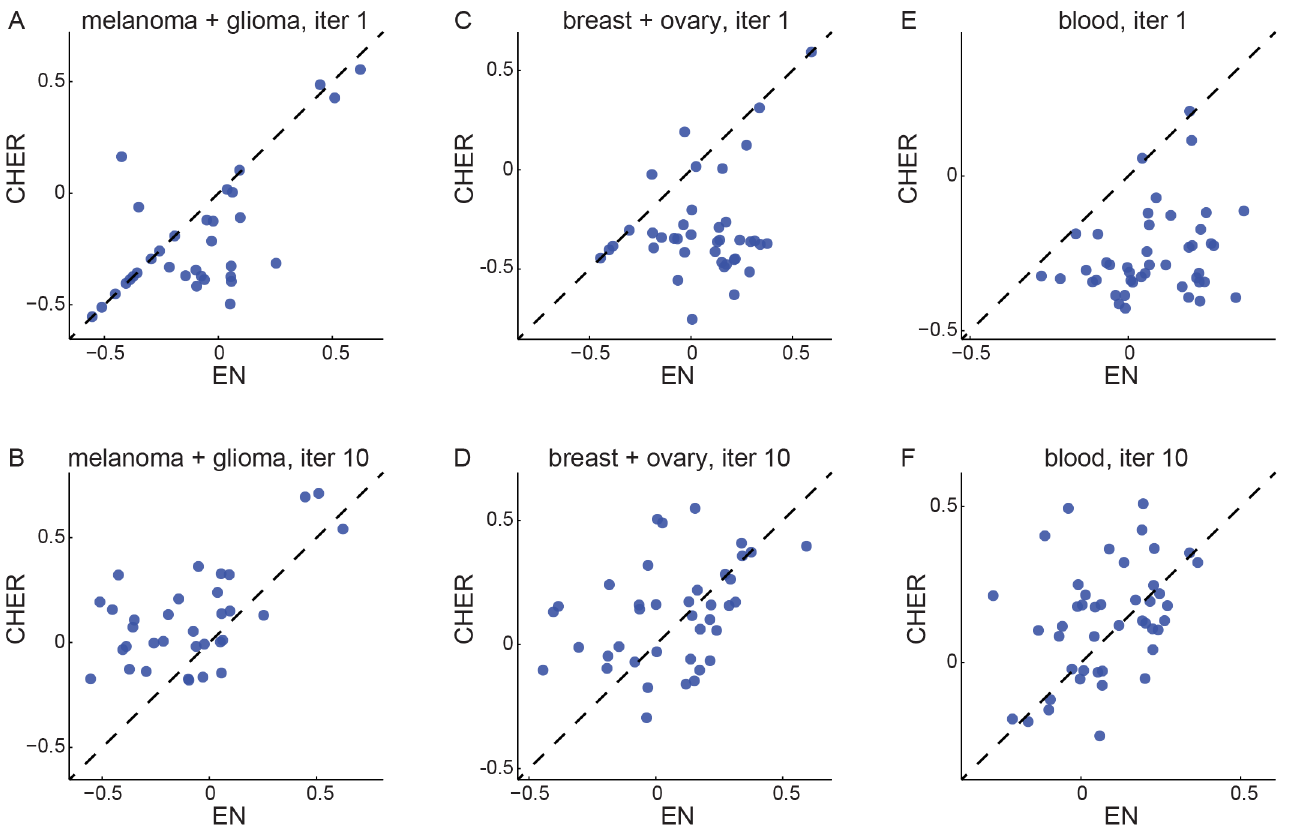
Fig 3. Comparison of performance between CHER and elastic-net (EN). Pearson ’ s correlation coefficients between the prediction and the true sensitivity data are calculated for each algorithm and plotted against each other (x-axis: elastic net, y-axis: CHER). Each dot represents a phenotype. A. Predictions for melanoma and glioma samples from the initial iteration of CHER algorithm are compared to those from elastic net. B. Predictions for melanoma and glioma samples from CHER after ten iterations are compared to those from elastic net. C., D. Similarly, but for breast and ovarian cancer samples. E., F. Similarly, but for blood